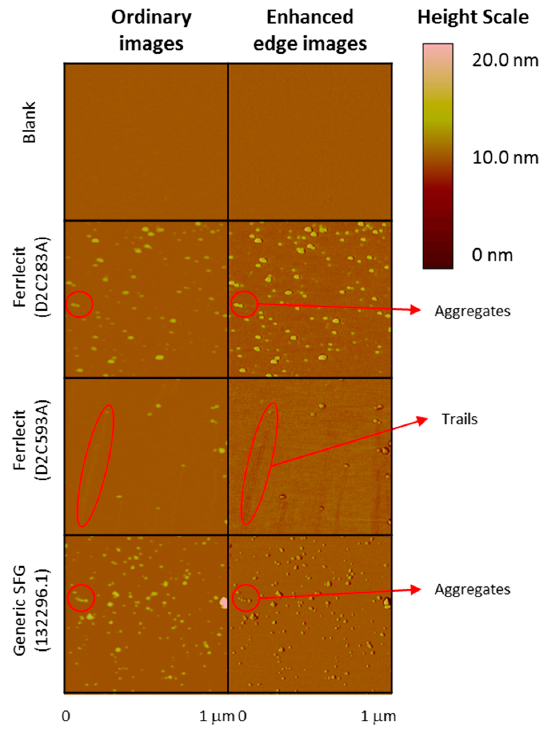
Figure 3. Topographic atomic force microscopy (AFM) ordinary and enhanced edge images of Ferrlecit (D2C283A and D2C593A) and generic SFG (132296.1).